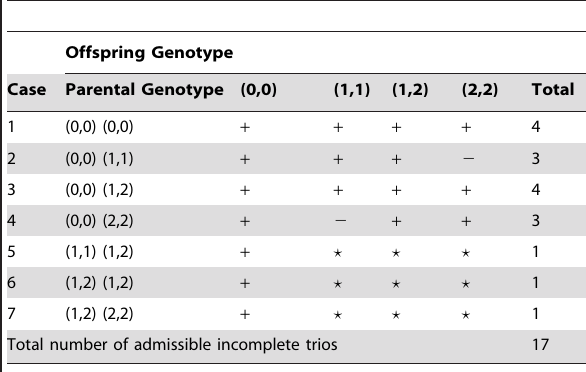
Table 4. List of admissible completions for cases